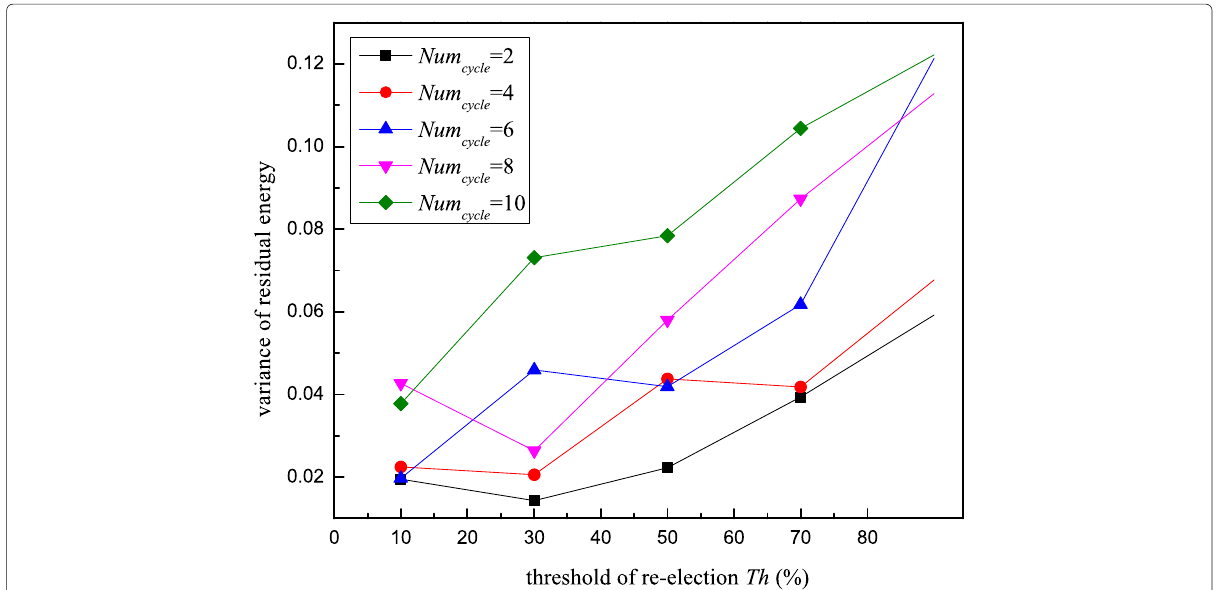
Fig. 11 The variance of residual energy under different system parameters (Th and Num cycle ). When Num cycle was 6 and 8, the variance values were close, and the network had a better performance regarding the lifetime and average residual